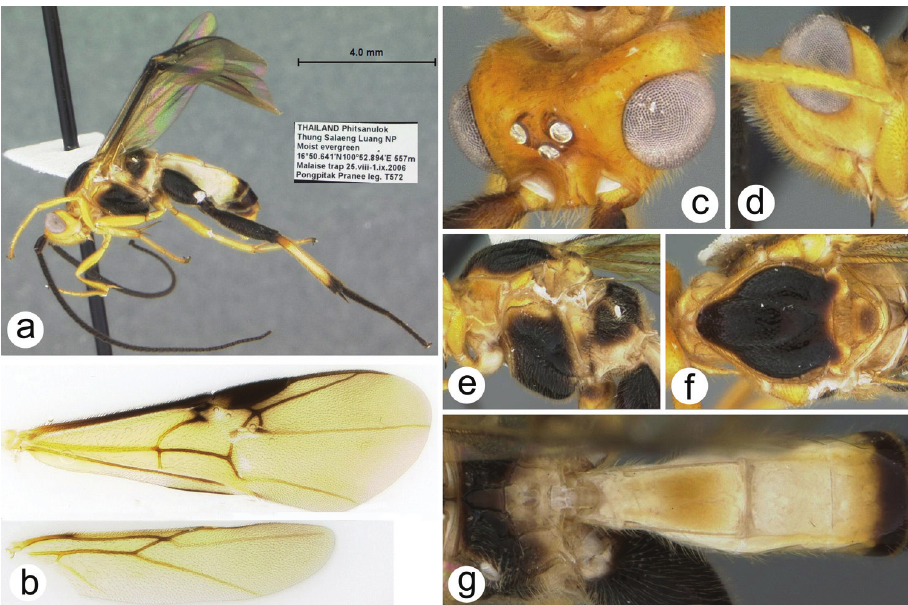
Figure 15. Zelodia saksiti sp.n. a lateral habitus b wings c dorsal head d lateral head e lateral mesosoma f dorsal mesosoma g dorsal propodeum and